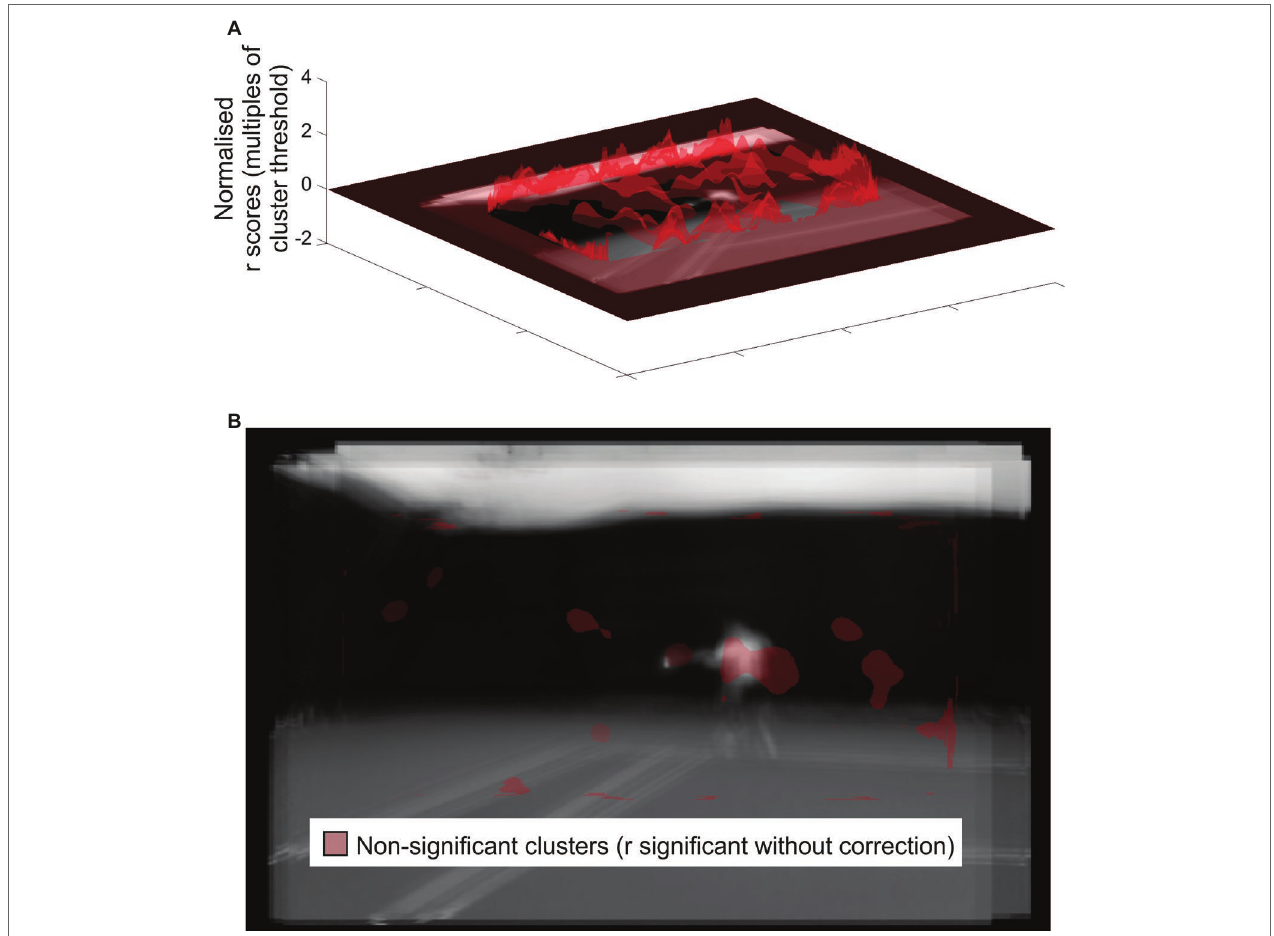
FIGURE 4 | Correlation results from the spatial bubbles experiment. Results are overlaid on an image of the mean of all presented videos for the frames capturing racket-ball contact, centered on the point of racket-ball contact (hence constituent images do not perfectly align). However, the results of the spatial analysis are not specific to any one time point. (A) Transparent red peaks denote correlations between classification-image intensities and discrimination performance, normalized to the cluster threshold value used in permutation testing (i.e., values more extreme than ±1 formed potential clusters). (B) Transparent red regions denote points where the cluster threshold (representing a significant correlation in the absence of familywise correction) was exceeded, but resulted in only nonsignificant